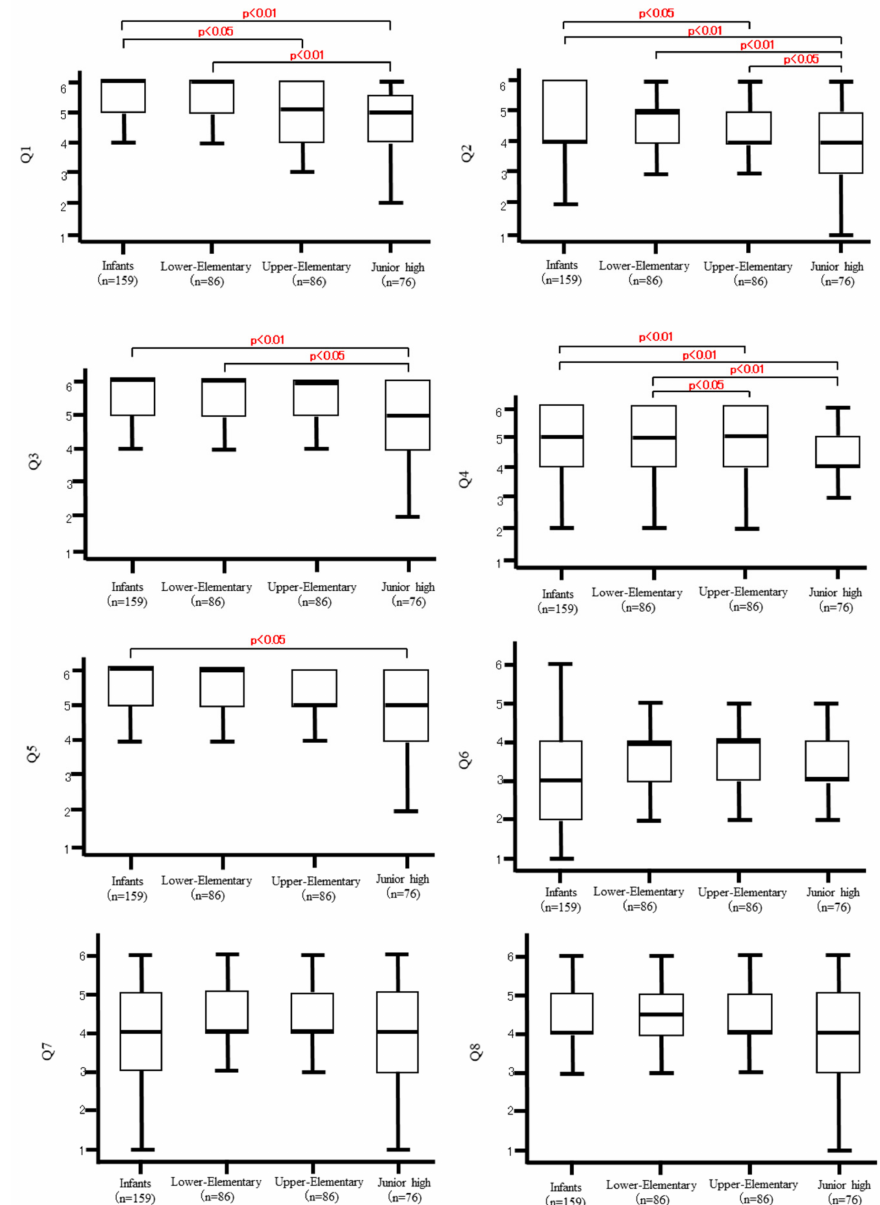
Figure 1. Effects of the stage of child development on the older